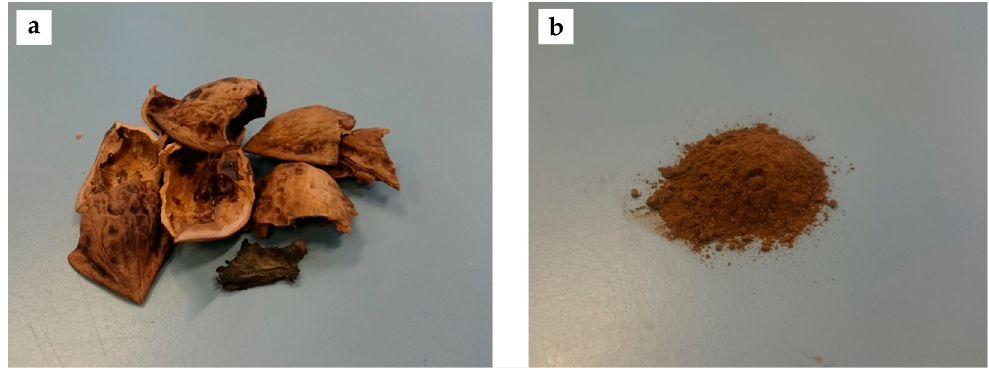
Figure 1. ( a ) Walnut shells; ( b ) walnut shell flour (WSF). Courtesy of Bazar al andalus